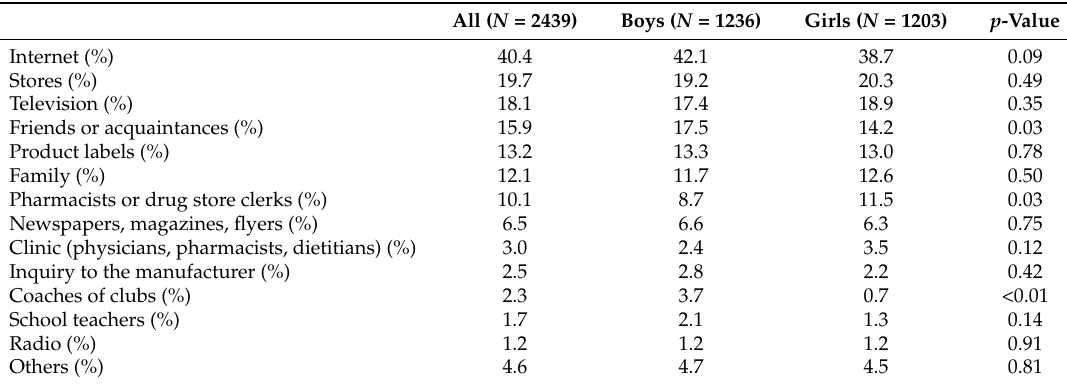
Table 3. How do you get information about dietary supplements?